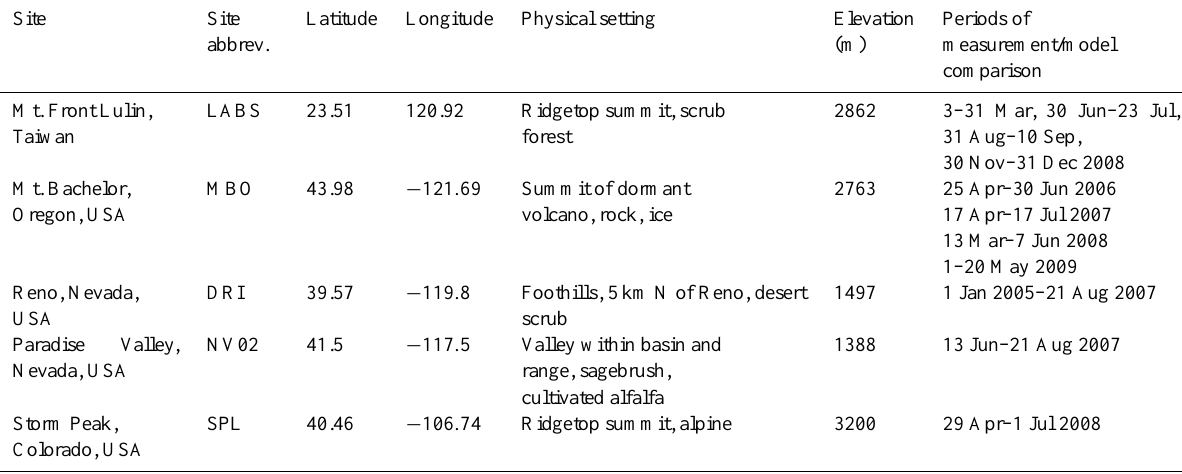
Table 1. Information on the five sites that are compared in this study ∗ (listed from west to east). Site Site Latitude Longitude Physical setting Elevation abbrev.